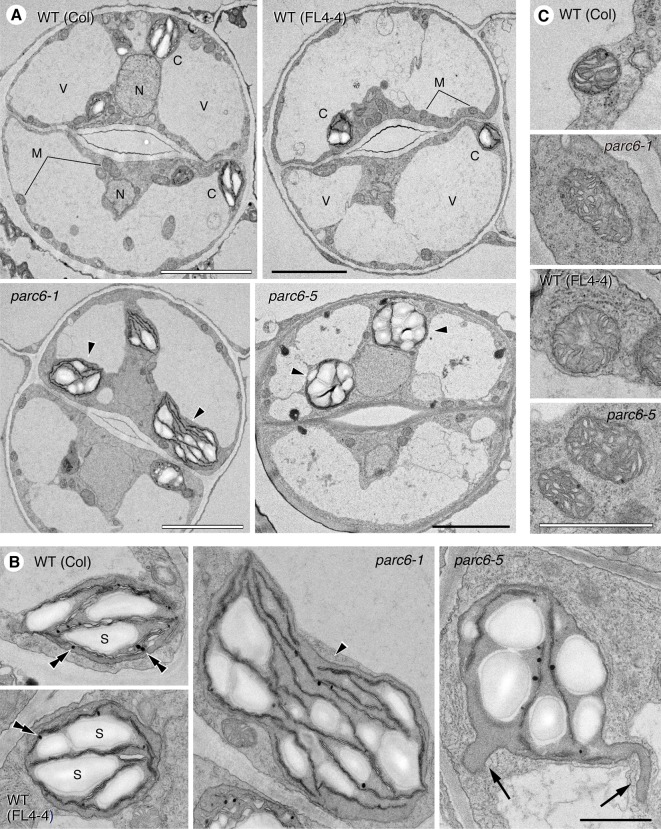
Ultrastructure of plastids and mitochondria in leaf stomatal guard cells of parc6 mutants. (A) Guard cells. (B) Plastids. (C) Mitochondria. Adaxial epidermis of the first leaf of 10-day-old WT (Col), WT (FL4-4 line), parc6-1 (Col-derived), and parc6-5 (FL4-4-derived) seedlings. Arrowheads, arrows, and double arrowheads indicate enlarged chloroplasts, stromules, and plastoglobules, respectively. Scale bars: 5 µm (A); 1 µm (B, C).